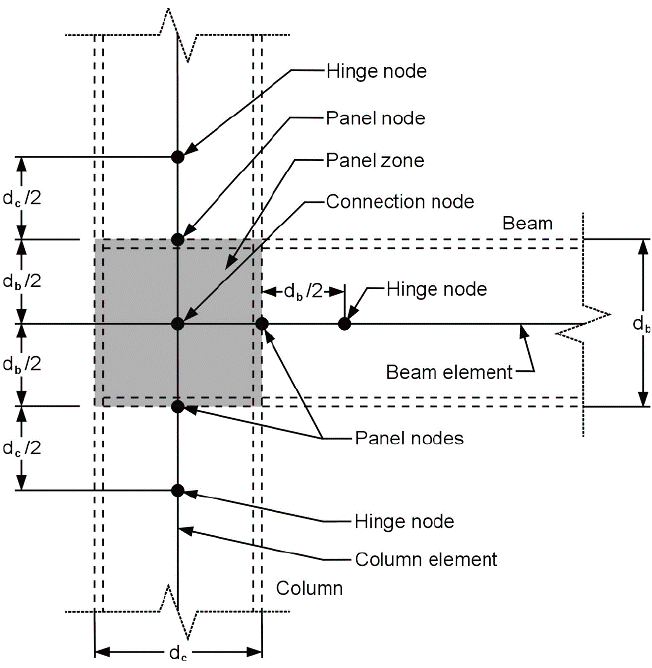
Figure 3. Frame-joint arrangement for moment-resisting connections in the modified strip model by Shishkin et al. [26]. Shishkin et al.